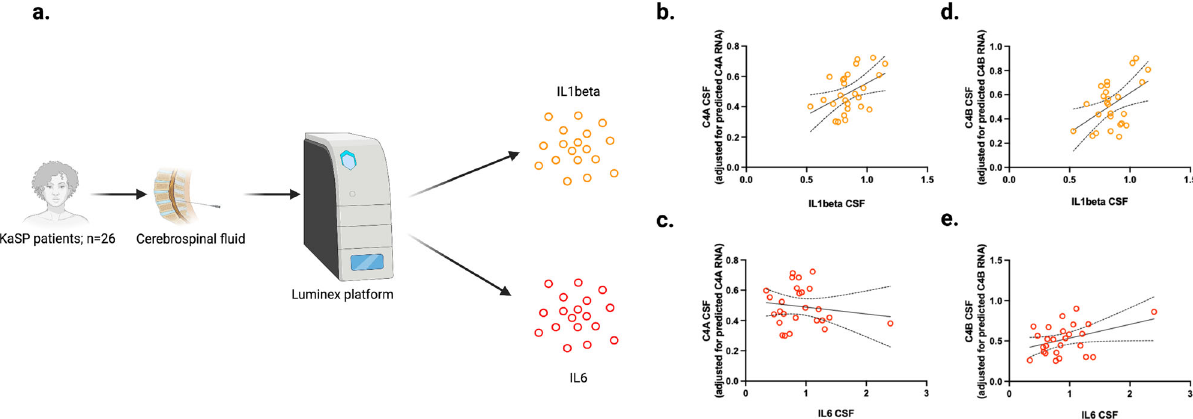
Fig. 3 | Disease-associated cytokines associate with C4A protein levels in cer- ebrospinal fl uidofpatientswith fi rst-episodepsychosis.a Overview of cytokine analyses.Cerebrospinal fl uid(CSF)frompatientswith fi rst-episodepsychosisinthe KaSP cohort ( n =26) were analyzed for interleukin (IL) − 1beta, IL-6, and C4A levels. Median age in the cohort was 29 years (interquartile range: 23-32) and 18 partici- pantsweremales. b CSFC4Aproteinlevels(adjusted forgeneticallypredicted C4A RNA expression) correlated with IL-1beta levels ( r =0.39; 95% con fi dence interval [CI]: 0.01 – 0.68, P =0.046), c but not IL-6 levels ( r = − 0.05 CI: − 0.44 – 0.36, P =0.820). c C4B protein levels (adjusted for genetically predicted C4B RNA